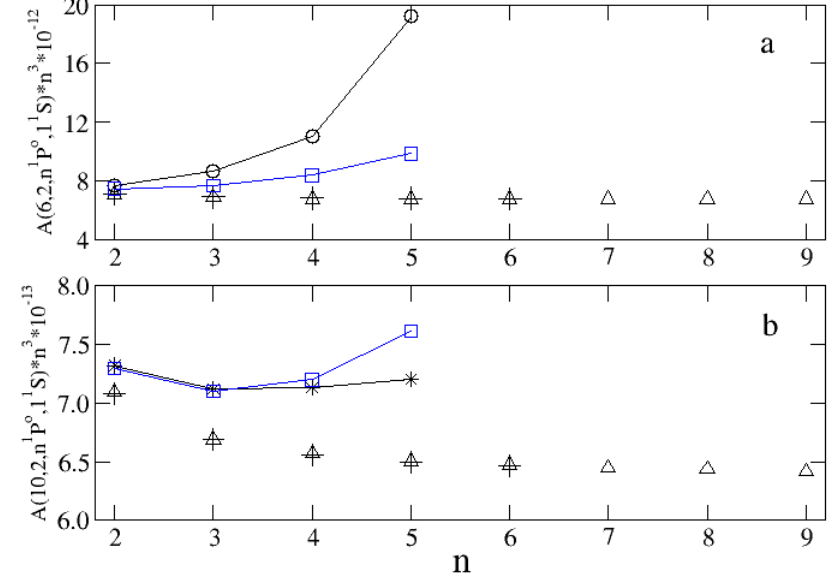
Figure 7. A ( Z, 2 , n 1 P o , 1 1 S) as a function of n for (a) Z = 6 and (b) Z = 10 . Circles: E1 MCDF calculation with GRASP for Z = 6 [124]. Stars: MCDF calculation with GRASP for Z = 10 [125]. Squares: Breit–Pauli CI calculation with AUTOSTRUCTURE , present work. Crosses: relativistic CI calculation [121]. Triangles: OP [129].